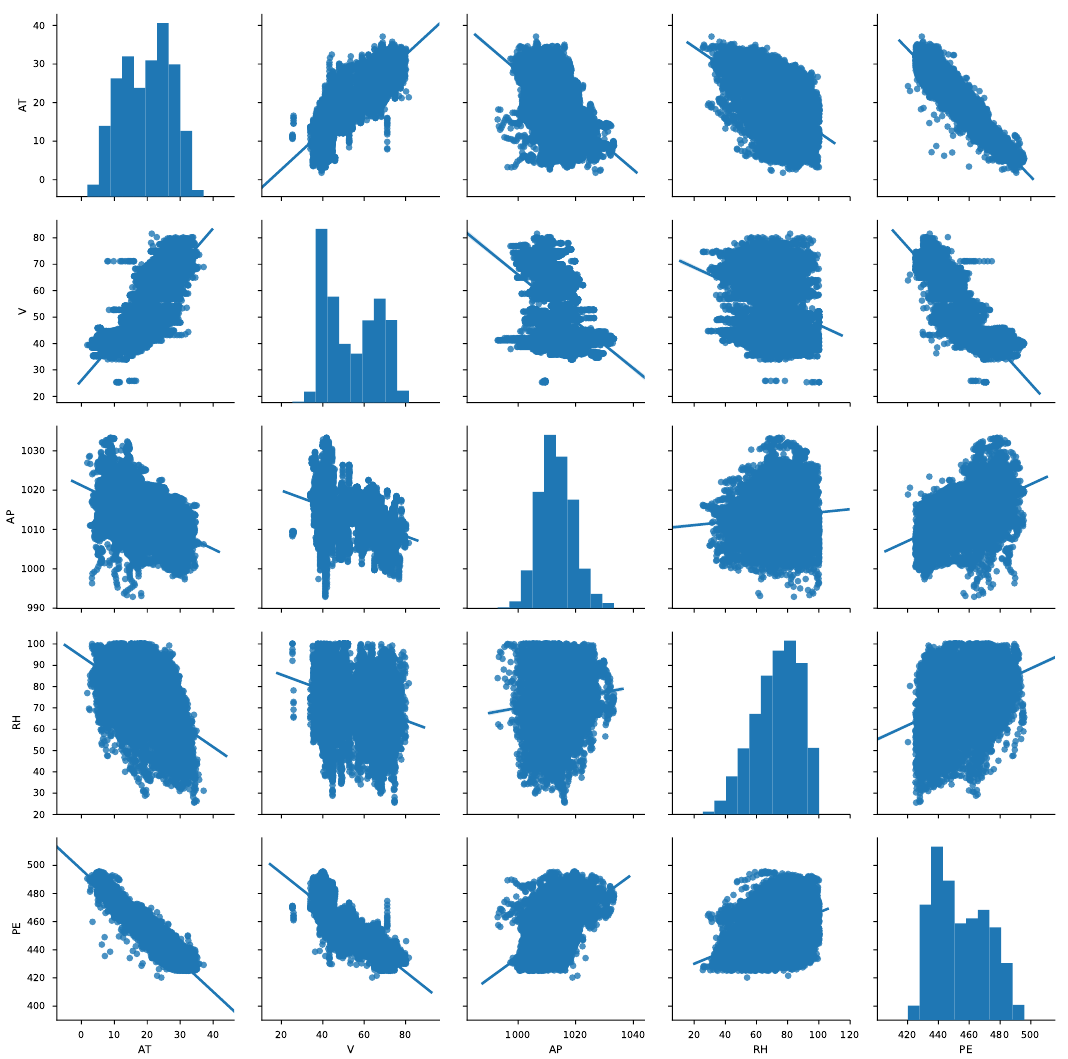
Figure 6. Scatter diagram for visualizing the correlation between features, and the linear regression model fit to the